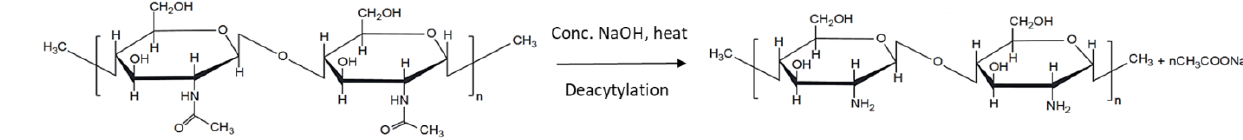
Figure 4. Deacetylation of chitin to chitosan.